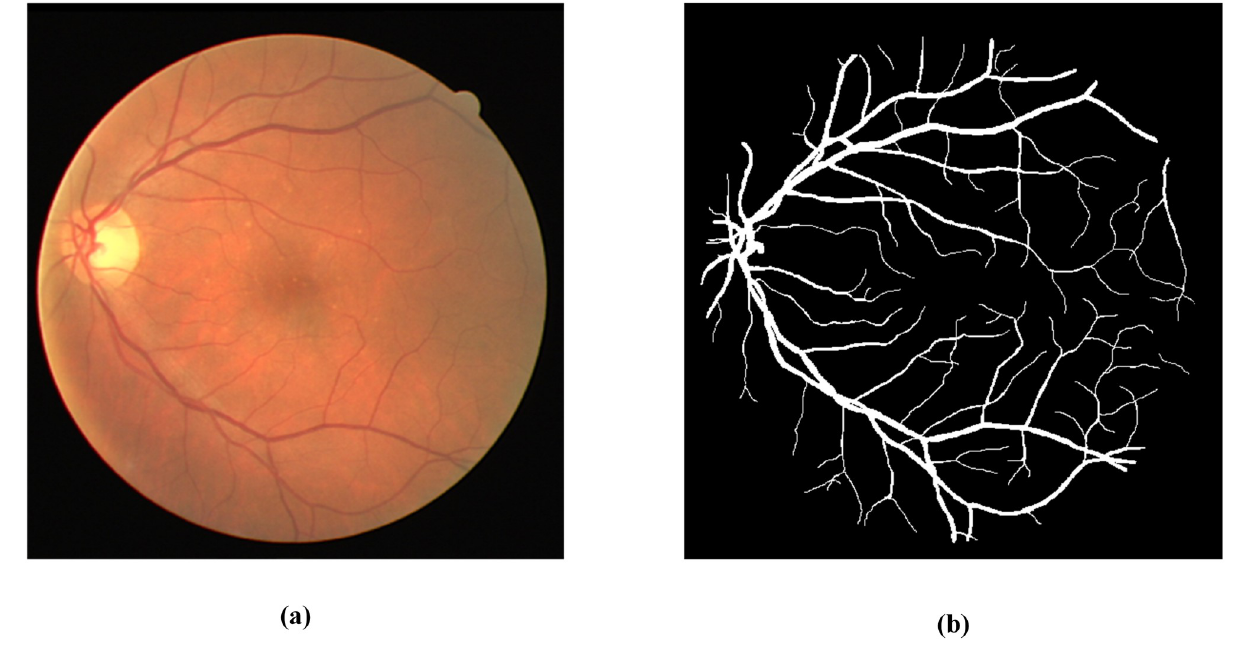
Fig 1. A retinal vessel segmentation instance. (a) a retinal image, (b) Corresponding segmentation